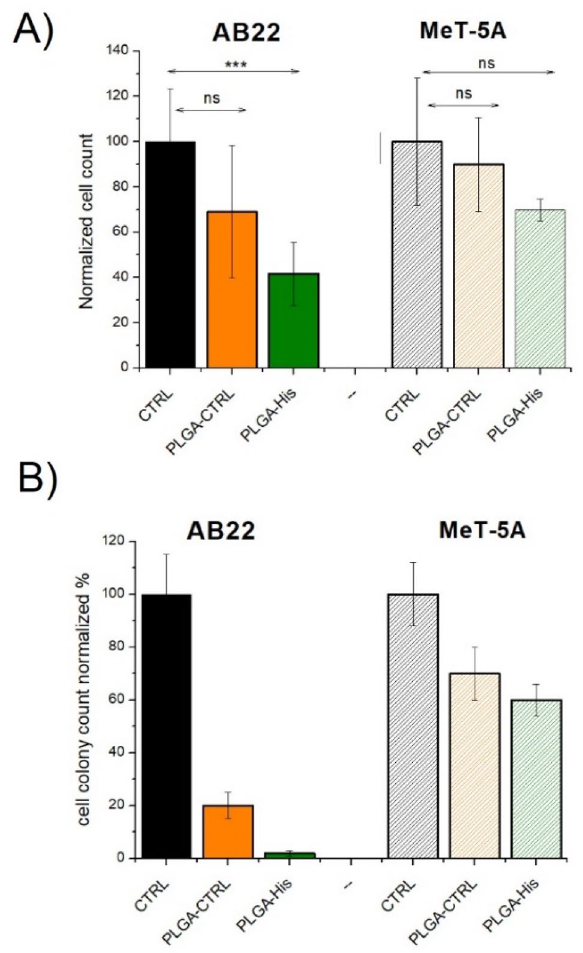
Figure 4. ( A ) Normalised cell count 24 h after neutron irradiation, performed on AB22 and MeT-5A previously treated with PLGA-CTRL or PLGA-His and compared to untreated cells. Statistical Significance was determined by Student T-test (***P < 0.01); ( B ) clonogenic assay performed 18 days after neutron irradiation. The number of colonies was calculated by ImageJ software. The % was calculated by setting the irradiated control cells to